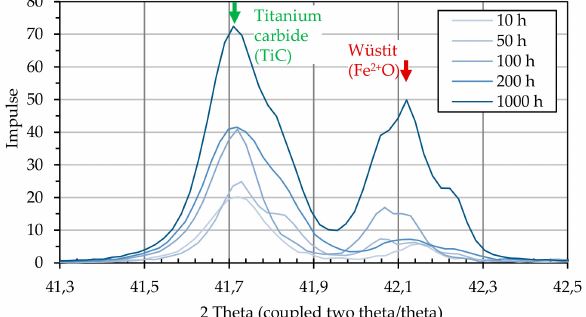
Figure 9. XRD measurement of Alloy 800H with enlarged representation of the decisive